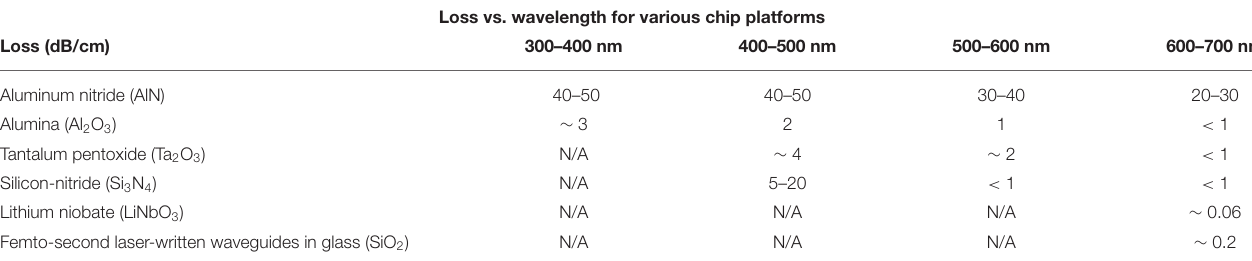
TABLE 1 | Data adapted from APL Photonics 5, 020903 (2020); Optica 6(3), 380-384 (2019); and Optics Express 14 (11), 4826-4834 (2006). Loss vs. wavelength for various chip